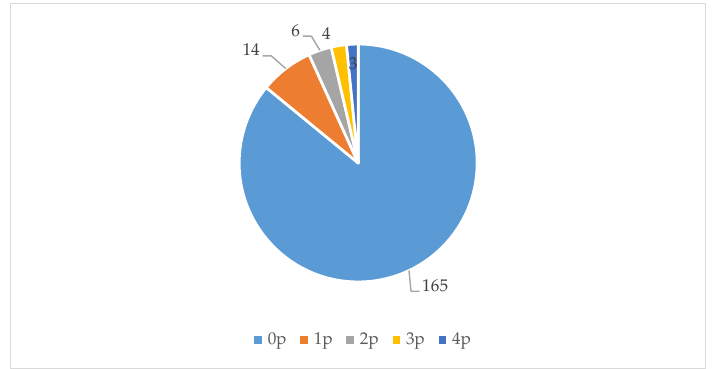
Figure 7. The number of people (p) observed during each measurement at Location 1.